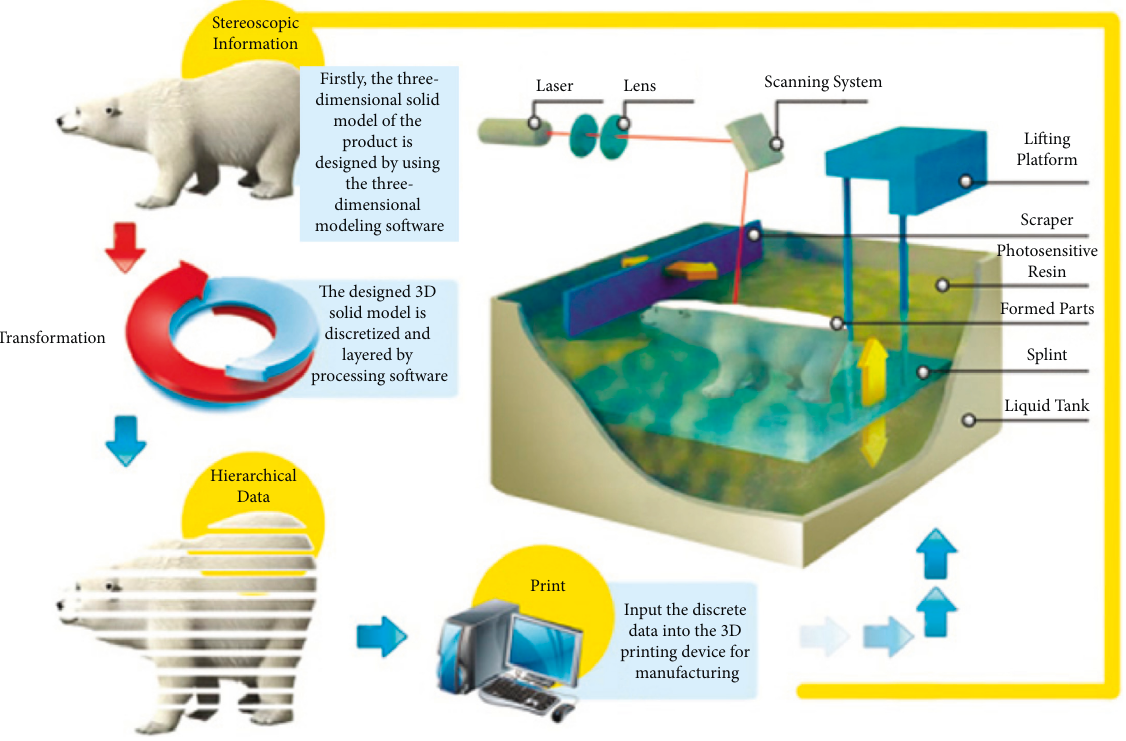
Figure 1: 3D printing